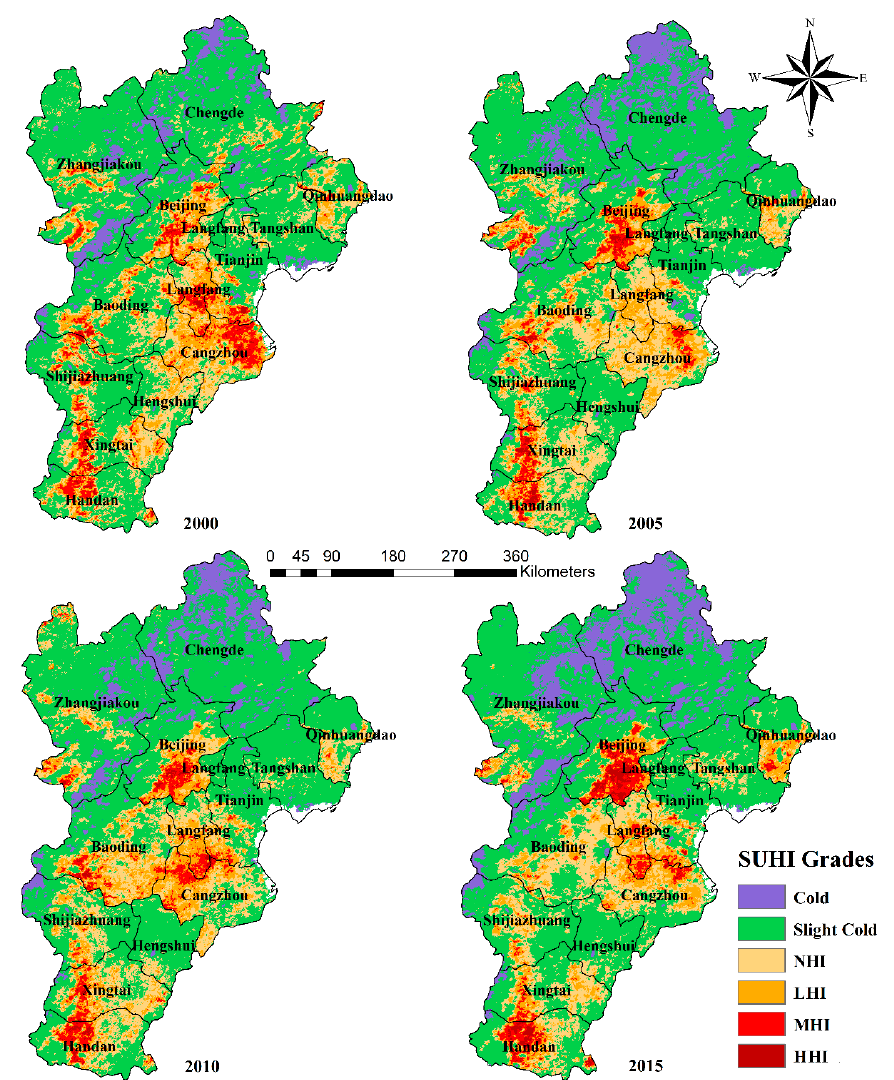
Figure 4. Spatiotemporal variation of SUHI in the BTH region in 2000, 2005, 2010, and 2015. Cold and slight clod refer to cold effect with temperature below comparison value; NHI refers to no heat island effect with a temperature above comparison value within 1 °C; LHI refers to light heat island effect with a temperature above comparison value within 1–2 °C; MHI refers to medium heat island effect with a temperature above comparison value within 2–3 °C; HHI refers to high heat island effect with a temperature above comparison value more than 3 °C.